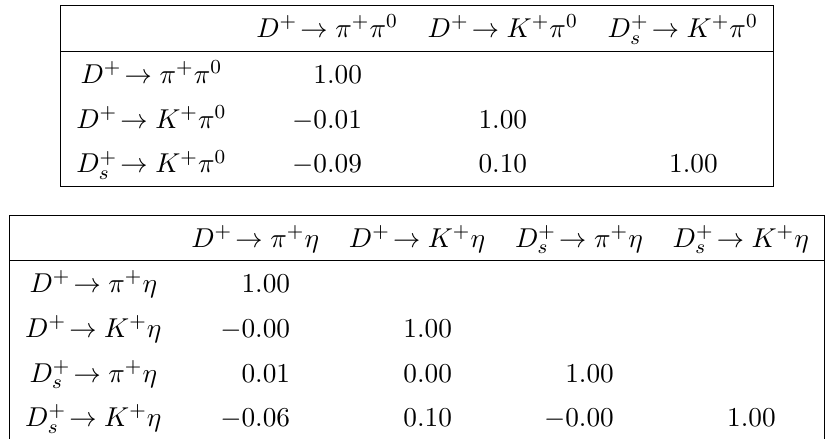
Table 2. Correlation coefficients between the raw asymmetries determined for D + D + → h + η ( s )